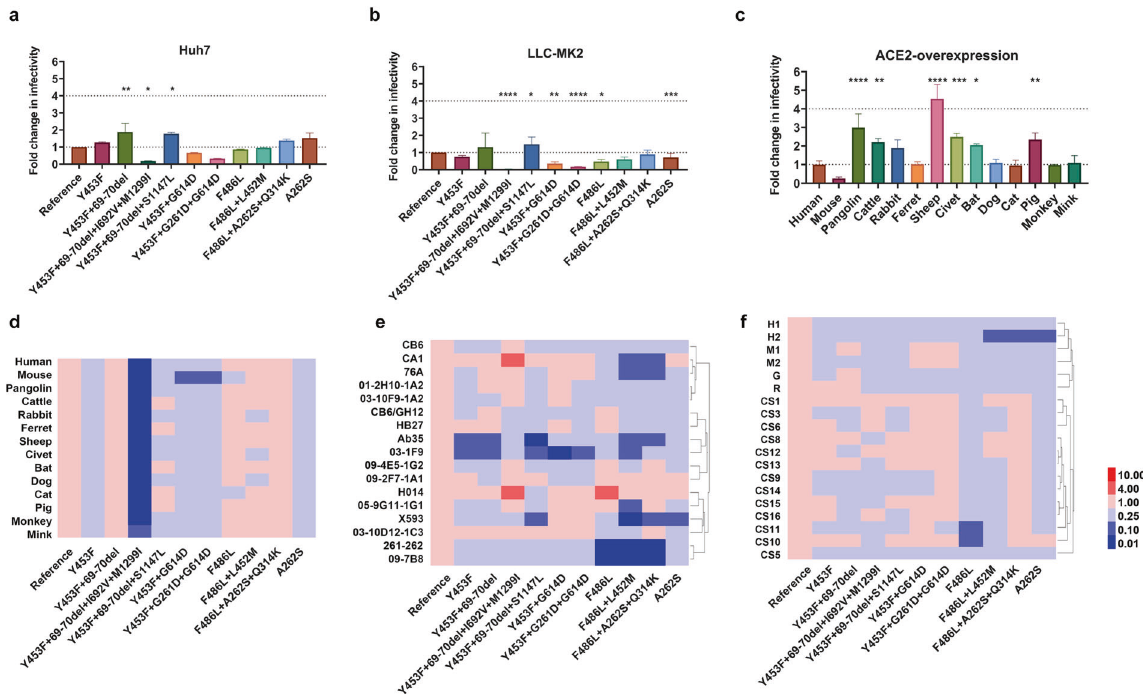
Fig. 1 The cells were infected with an equal amount of 11 pseudoviruses. The luminescence activity was analyzed 24 h after the infection. The mean ratio of the RLU values of mink-derived variant to the reference strain (D614G) was calculated and presented in a – d . a Infection of human cell line by the mink variants. b Infection of monkey cell line by the mink variants. c Infection of reference strain (D614G) in different ACE2 over-expressed 293T cells. d Infection of reference and ten variants in 14 different ACE2 over-expressed 293T cells (heatmaps). e Antigenicity analysis of the mink mutants in 17 monoclonal antibodies (heatmaps). f Antigenicity analyses of mink variants with polyclonal antibodies (heatmaps). CS denotes: convalescent plasma, H: horse, G: goat M: mouse. Data represent the ratio of variants/D614G in EC 50 ( e , f ). The red and blue boxes indicate the increase or decrease of the infectivity ( d ) or neutralization activity ( e , f ) as shown in the scale bar. Three to six times experiment results were